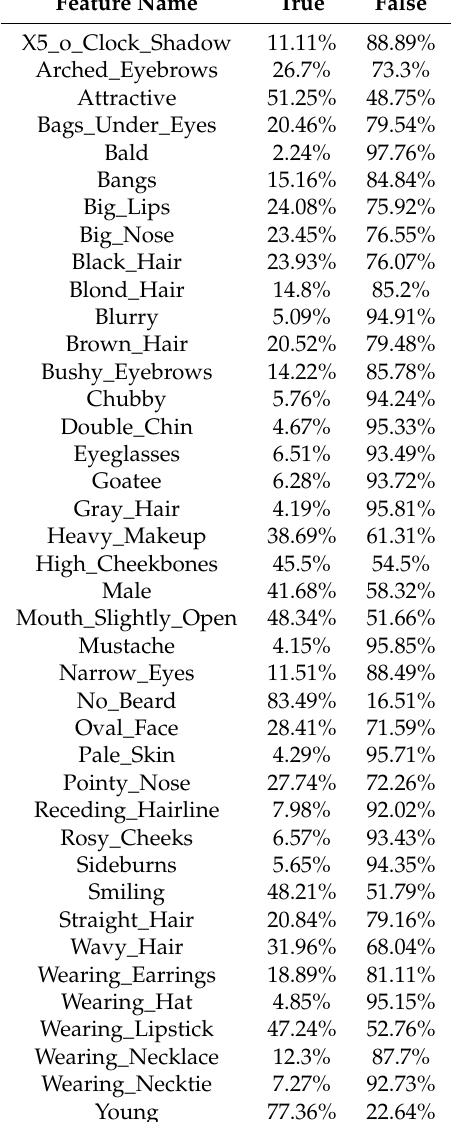
Table 1. The distribution of binary annotations in the data set. For example, 4.15% of images contain people with